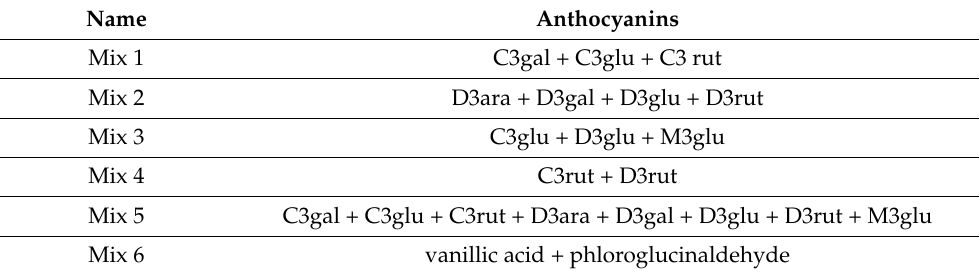
Table 1. Anthocyanin mixtures used; concentrations were equimolar cumulative.